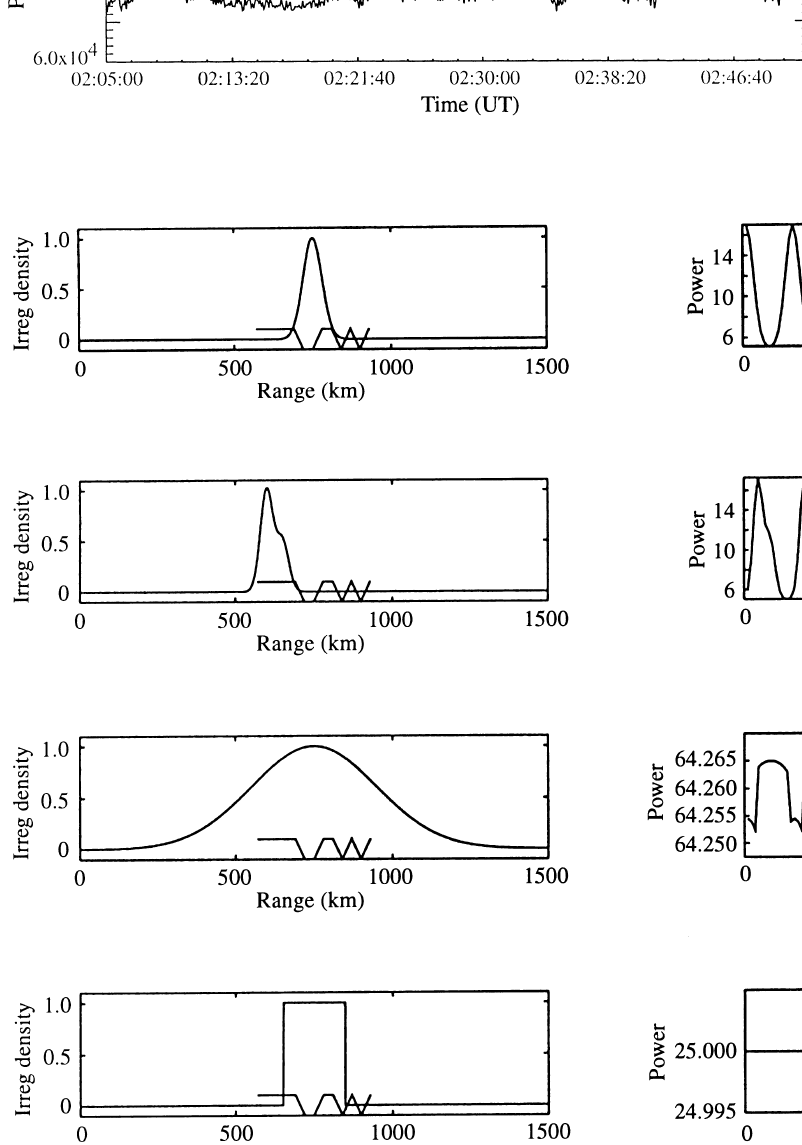
superimposed to the correct scale. The right-hand column illustrates ten cycles of the modelled Barker response function. The reader should note the di(cid:128)erent y -axis scales in the right-hand column of